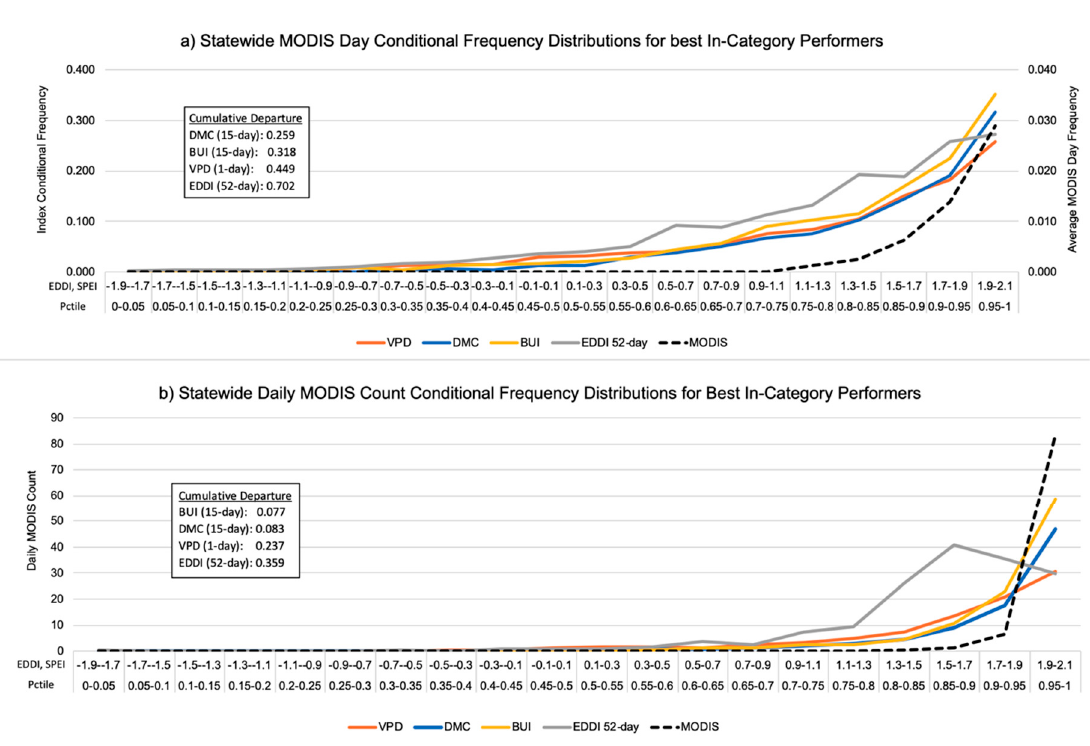
Figure 9. MODIS Count conditional frequency cumulative departure helps to identify how well each index captures the trend in fire growth potential. The color ramp highlights comparison of cumulative departure scores for each index (darker red shading indicates larger departures) within each column.